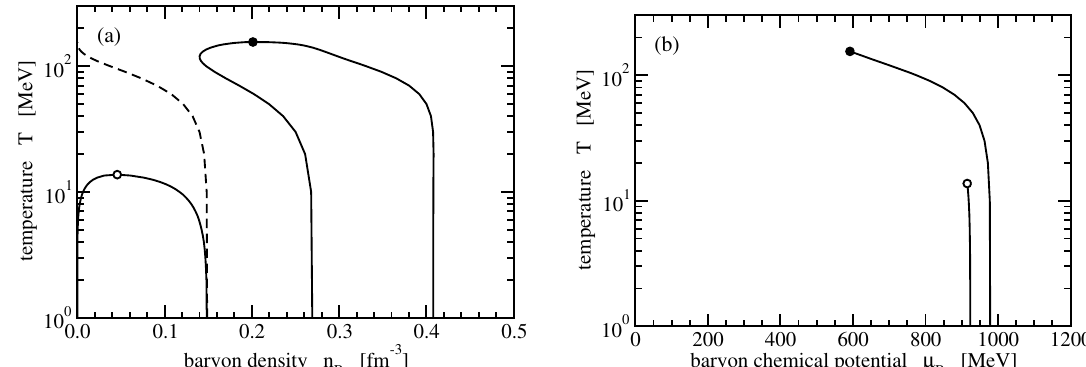
Figure 2. Binodals (full lines) and critical points (full and open circles) of isospin-symmetric strongly interacting matter in ( a ) the temperature–baryon density diagram and ( b ) the temperature–baryon chemical potential diagram. The dashed line in panel ( a ) separates the region without effects of the modified excluded-volume mechanism (lower left) from the region with effects (upper right). Results for the liquid–gas phase transition are shown at subsaturation